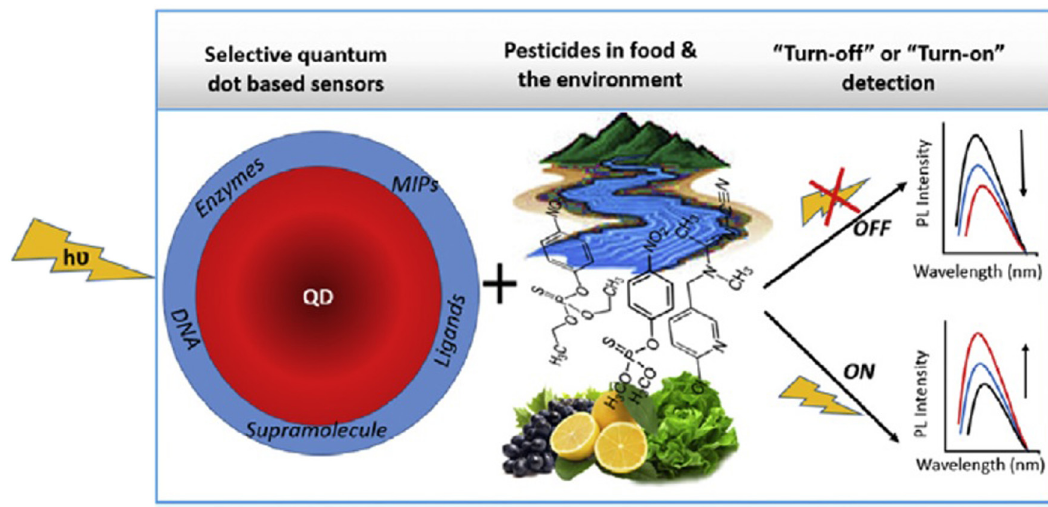
Figure 10: Di ff erent QDs for pesticides in food and in environment [ 38 ]